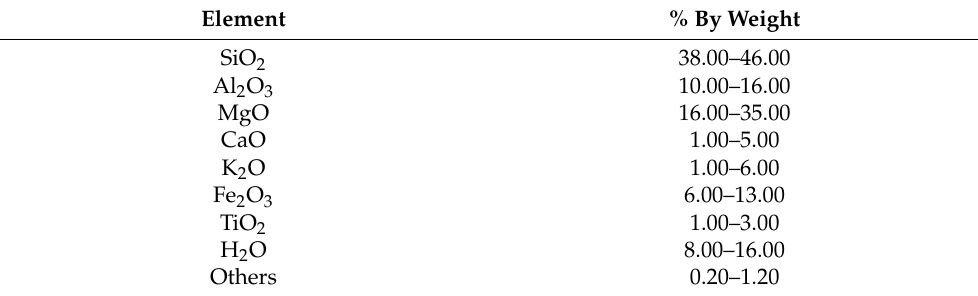
Table 1. Constituent elements of vermiculite [15].